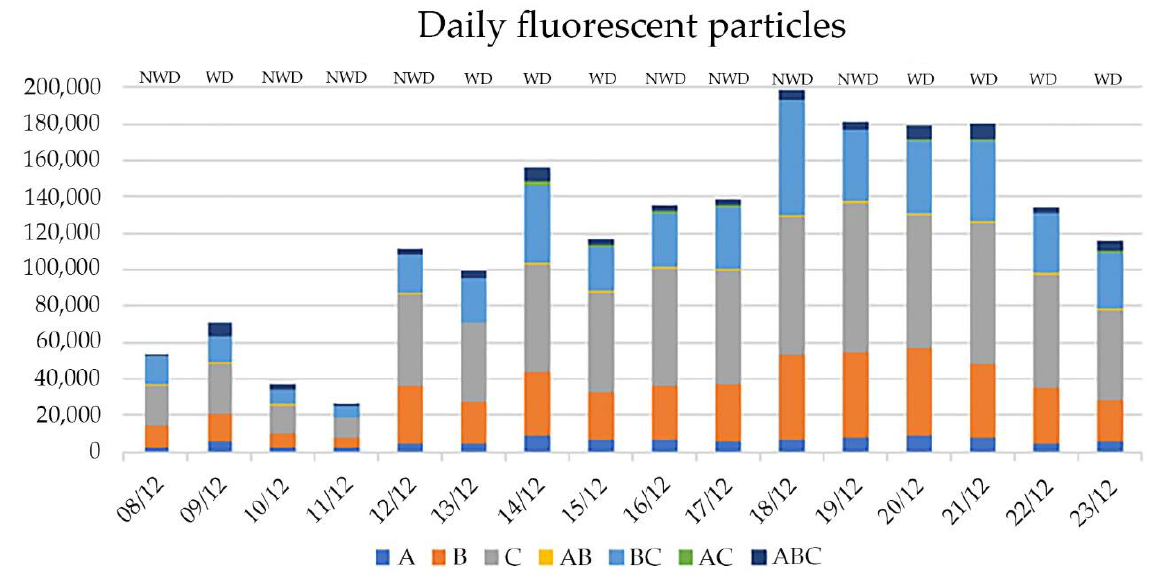
Figure 2. Number particles (y-axis) for each day of sampling (x-axis).